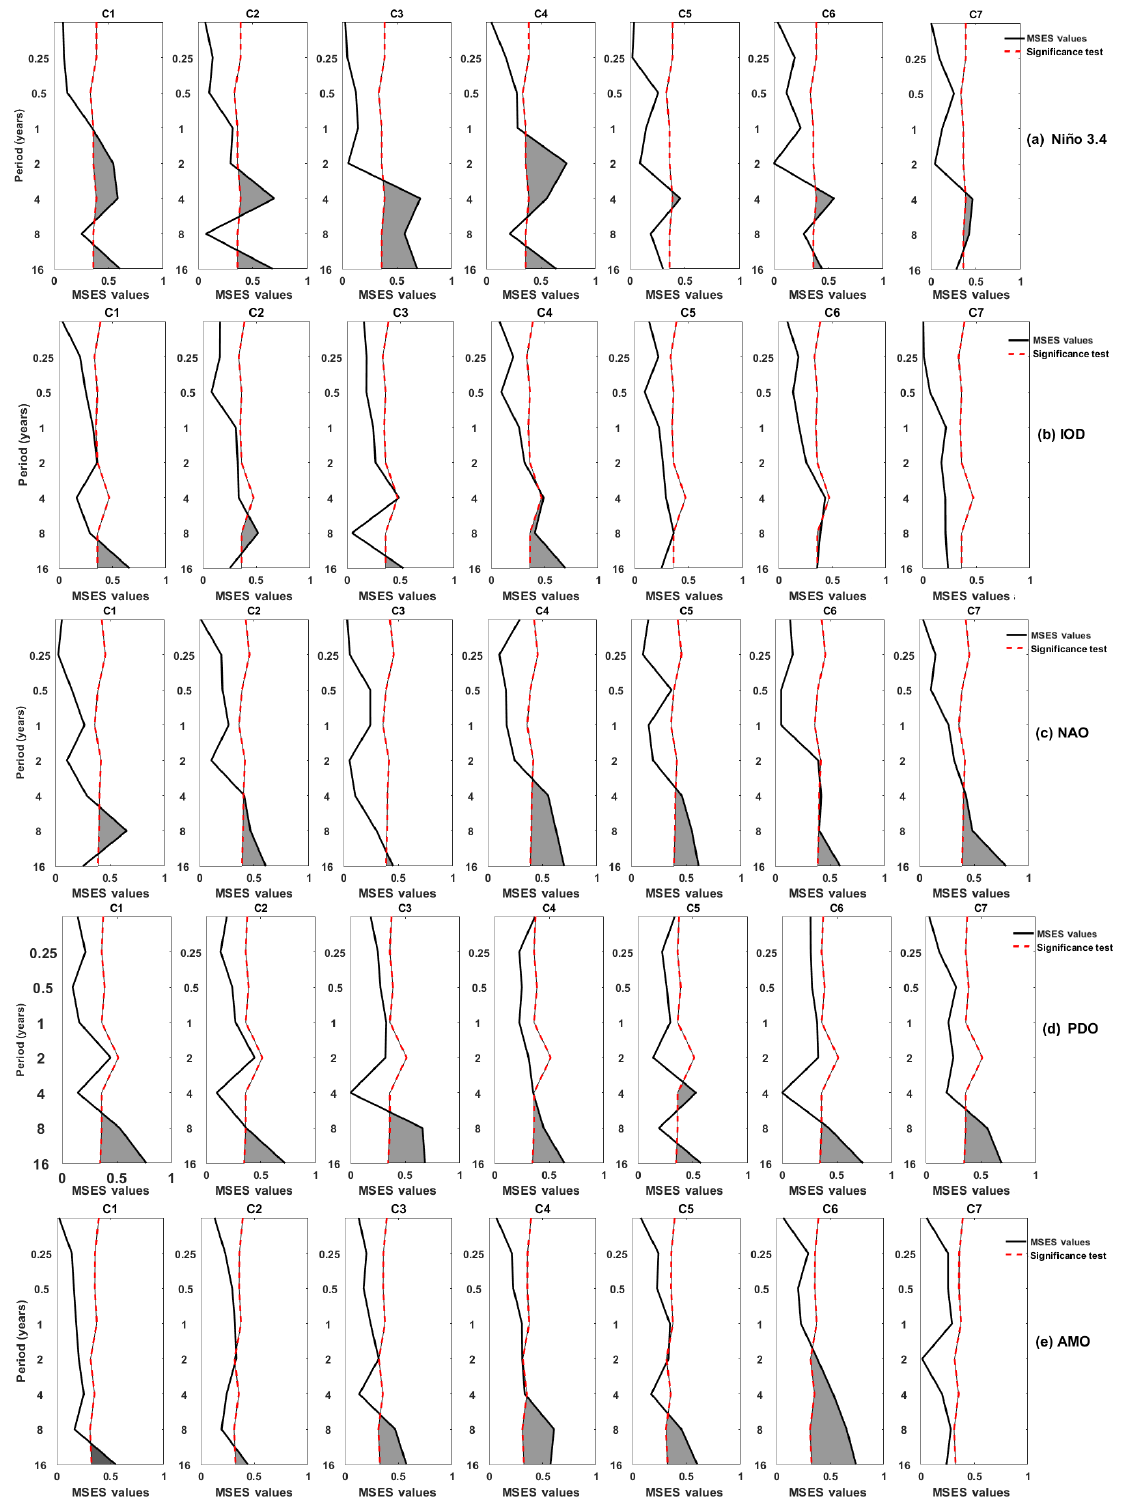
Figure 5. Multiscale event synchronization (MSES) between precipitation and climate indices. From top to bottom: Niño 3.4, IOD, NAO, PDO, and AMO. From left to right: community 1 to community 7. MSES values are shown as solid lines, and significant connections (at the 95% significance level) are marked in